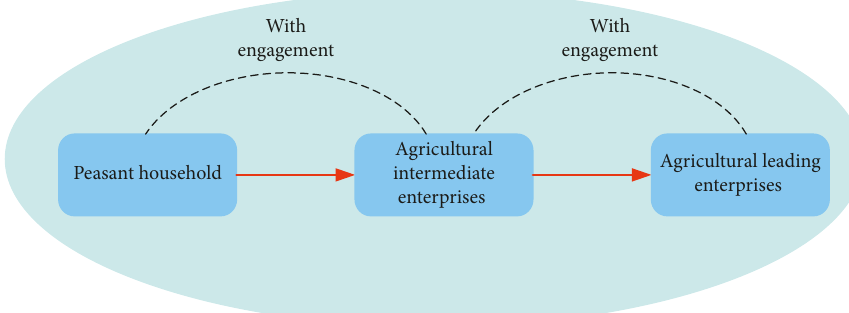
Figure 4: Schematic diagram of overall cooperative agricultural industry chain construction.